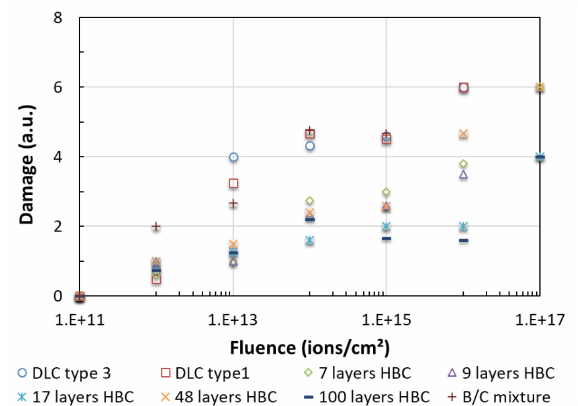
Fig. 3. The damage degree of 8 types of foils under different magnitudes of ion